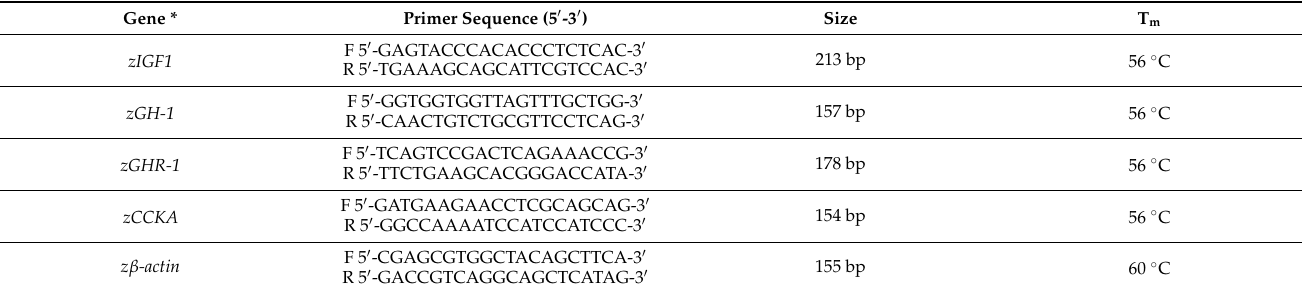
Table 2. Zebrafish primers and PCR conditions used in this